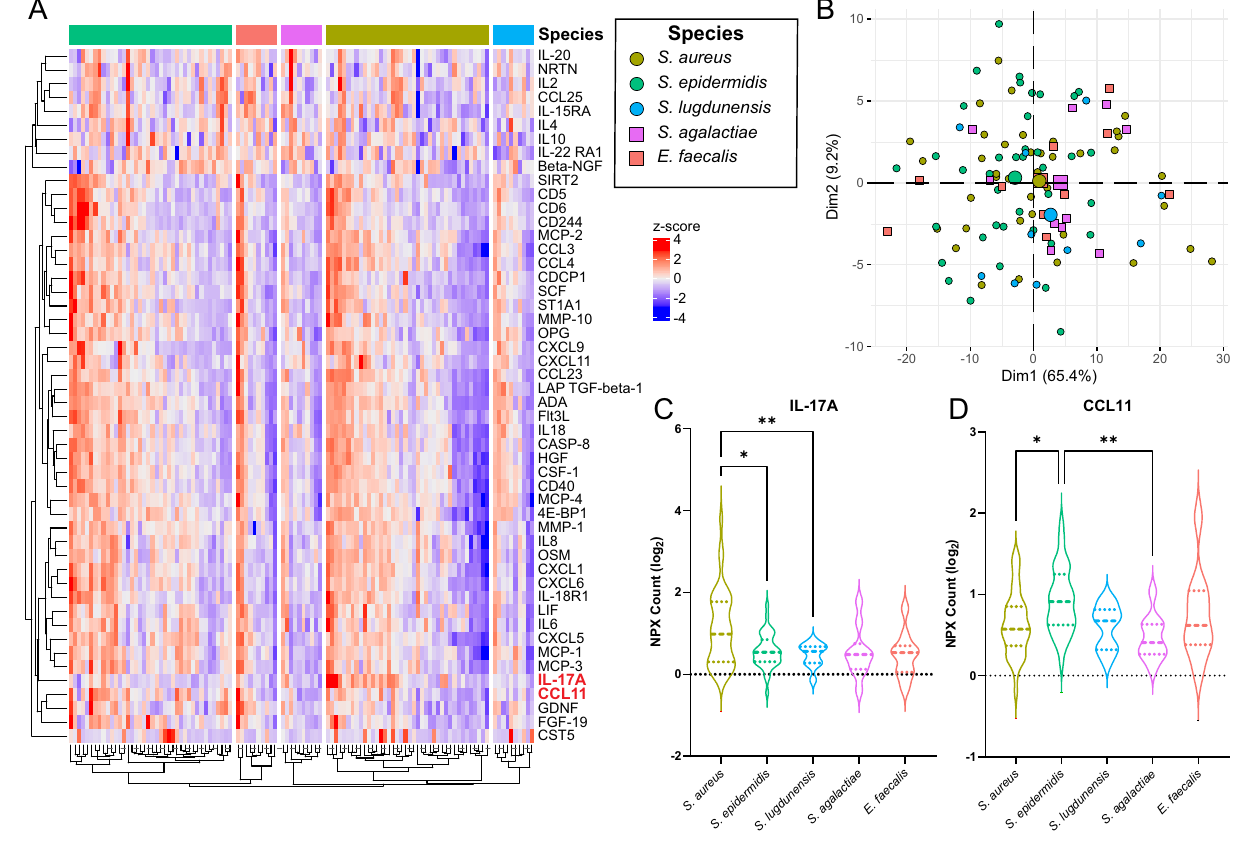
Figure 3. Analysis of staphylococcal versus non-staphylococcal and species versus species periprosthetic joint infection (PJI) using the Olink Proteomics Inflammation Panel. ( A ) Heatmap analysis of protein expression z-scores in each PJI-causing bacterial species examined, with the 50 most statistically significant protein targets clustered and shown. IL-17A and CCL11 (highlighted in red) were the only protein targets statistically differentially expressed in any species versus species PJI-causing bacterial species pairing. ( B ) Principal component analysis (PCA) showing grouping of staphylococcal (circles) versus non-staphylococcal (square) PJI and species versus species PJI-causing bacterial species (indicated by colors) based on Dim1 and Dim2. Larger points indicate geometric means of the sample population. Normalized protein expression (NPX) counts